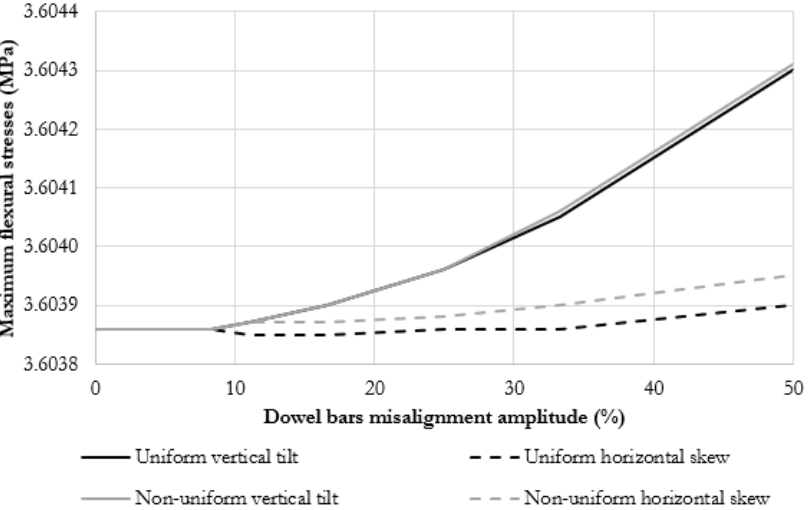
Figure 9. Flexural stresses in concrete slab bonded to asphalt base for top-bottom thermal differential of